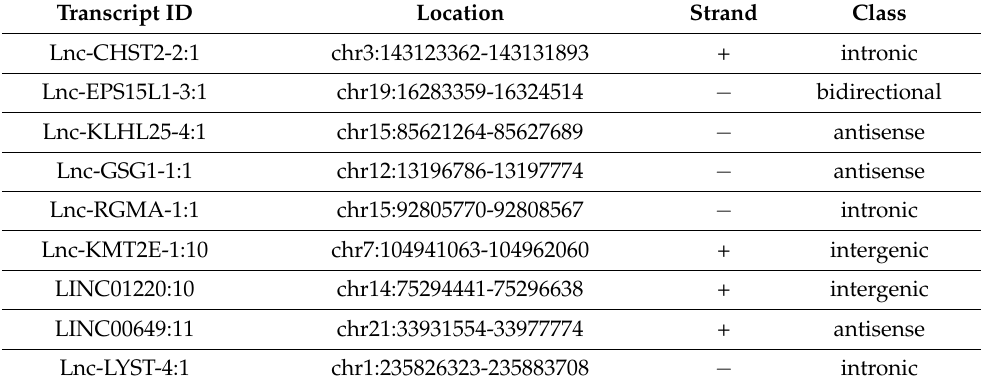
Figure 2. Workflow and selection process of the micro-array analysis. Table 2. Overview of the characteristics of the upregulated LSC lncRNA (unique and shared with the L-blast fraction (LNCipedia, version